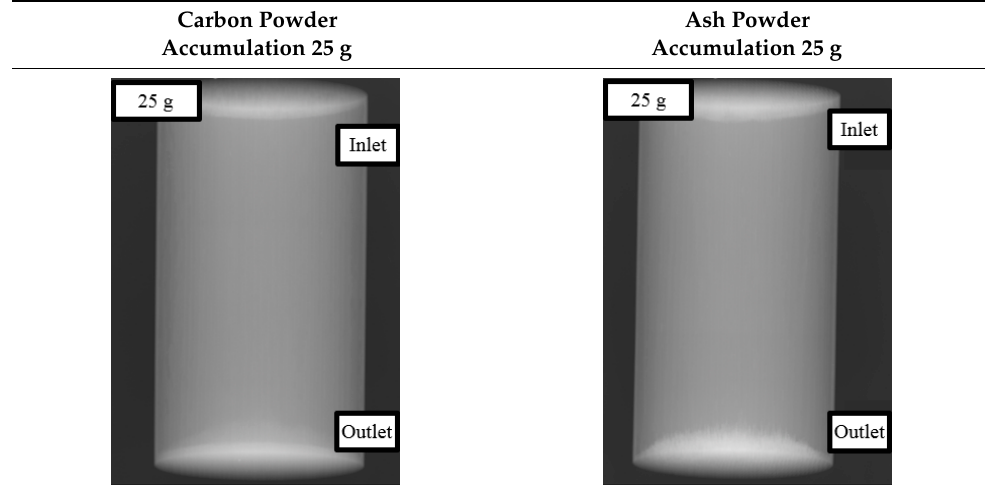
Figure 10. Pixel values comparison of carbon powder and ash powder. 3.3. Summary of Verification Results and Observations It is confirmed that the area accumulated with carbon powder or with ash powder appeared white based on CR X-ray images and that the color of the area of accumulated ash powder was whiter. In addition, it is verified that it is possible to analyze the accumu- lation status by comparing pixel values produced by Image J. Therefore, this study shows that it is confirmed to be technically possible to diagnose the accumulation status of soot and ash using the CR X-ray imaging technique and Image J. However, although the qual- itative evaluation through CR X-ray images has been sufficiently proven, the numerical values obtained through Image J are only pixel values, so it is not enough to be called a quantitative evaluation. In order for the pixel values obtained to be demonstrated by quantitative evaluation, additional studies are needed, such as uncertainty analysis. In addition, as the substrate without canister was photographed, research is necessary to analyze whether soot and ash are accumulated in the DPF of in-use vehicles, and more thought should be given to the adaptability of the technique. In recent years, various radiation studies have been conducted, including experi- ments to evaluate X-ray-radian and gamma-radian-based systems using Monte Carlo ra- diation transmission tools [17–20]. The CR X-ray imaging technique is expected to make contributions to the environment by diagnosing whether a DPF is damaged and detecting illegal remodeling at vehicle inspection stations. It is also expected to be used for various purposes, such as for DPF cleaning shops and retrofit manufacturers to determine whether the DPF is sustainably usable after a cleaning process or needs to be repaired. As